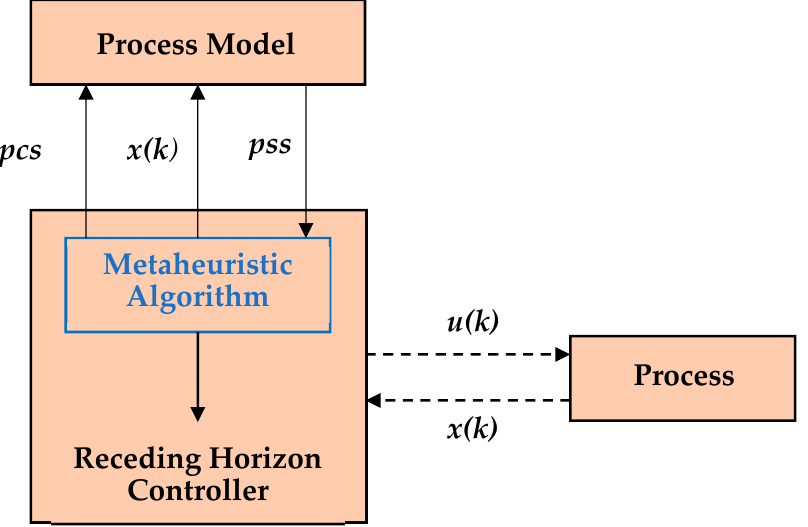
Figure 1. The principle of Receding Horizon Control using